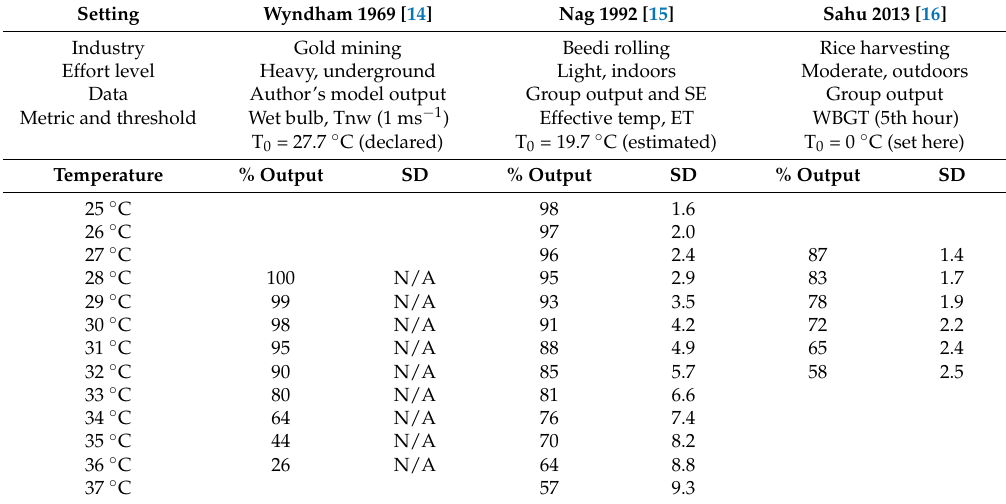
Table 1. The summary of examples.